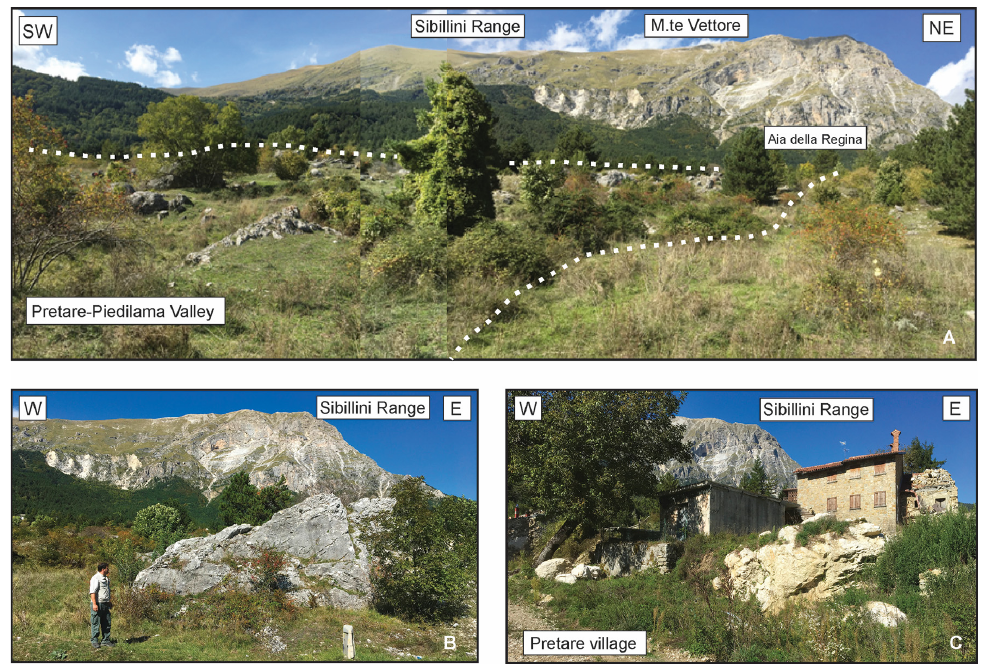
Figure 2. ( A ) panoramic view of the clastic deposits filling the Pretare ‐ Piedilama Valley, and the Sibillini Range in the background; ( B ) huge, sharp rock block lying in the mid ‐ sector of the valley; ( C ) rock blocks of the Pretare village. ( C ) rock blocks of the Pretare